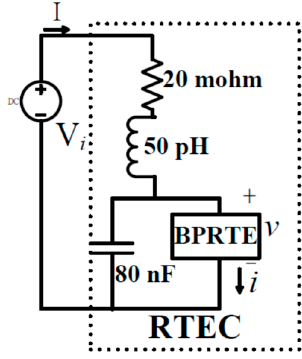
Figure 4. Optimum single PVCDR RTEC equivalent circuit with C p of 80 nF, R S of 20 m Ω and L S of 50 pH values [1].